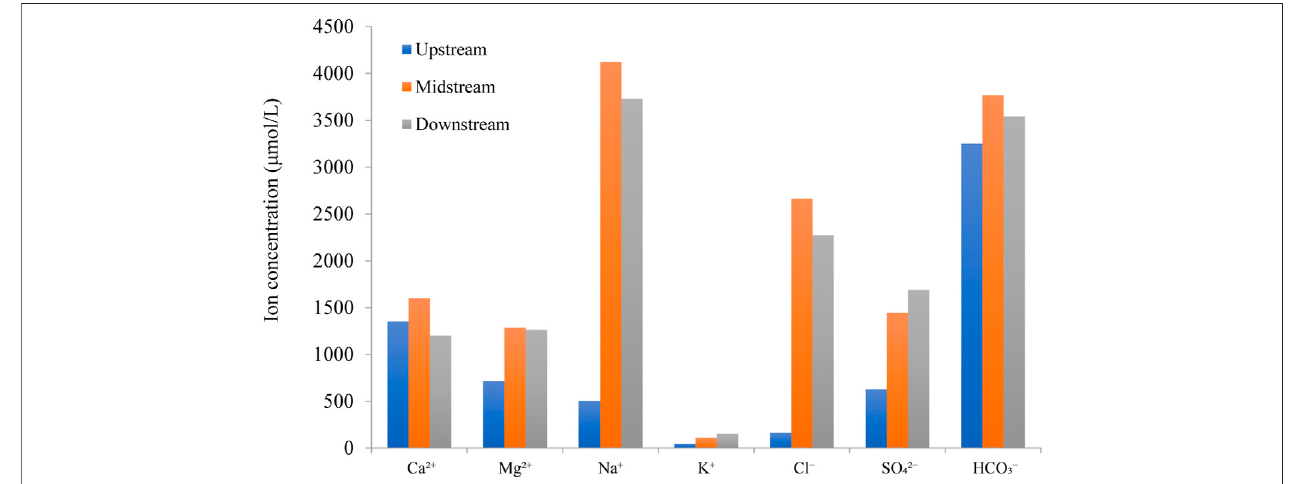
FIGURE4| Comparisonofthemajorionconcentrationintheupper,middle,andlowerreachesoftheYellowRiver.Themajorionconcentrationsaretheaverageof river waters collected weekly in the upstream (this study), midstream (Longmen), and downstream (Lijin). The midstream and downstream data come from Zhang et al. (2015) and Ran et al. (2015),